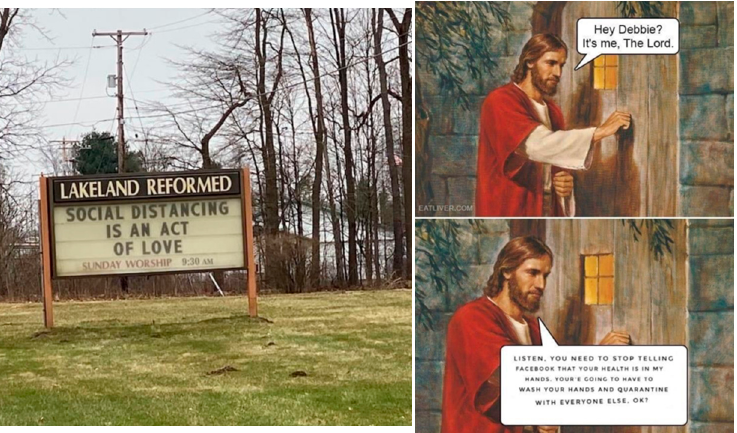
Figure 3. Examples of church sign memes and Jesus memes emphasising that social dis- tancing should be seen as a Christian